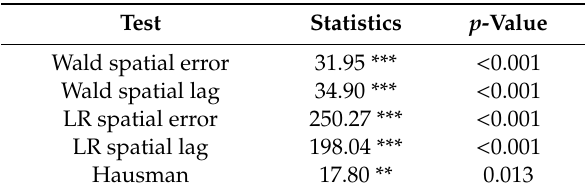
Table 2. Wald, likelihood ratio (LR) and Hausman test results.